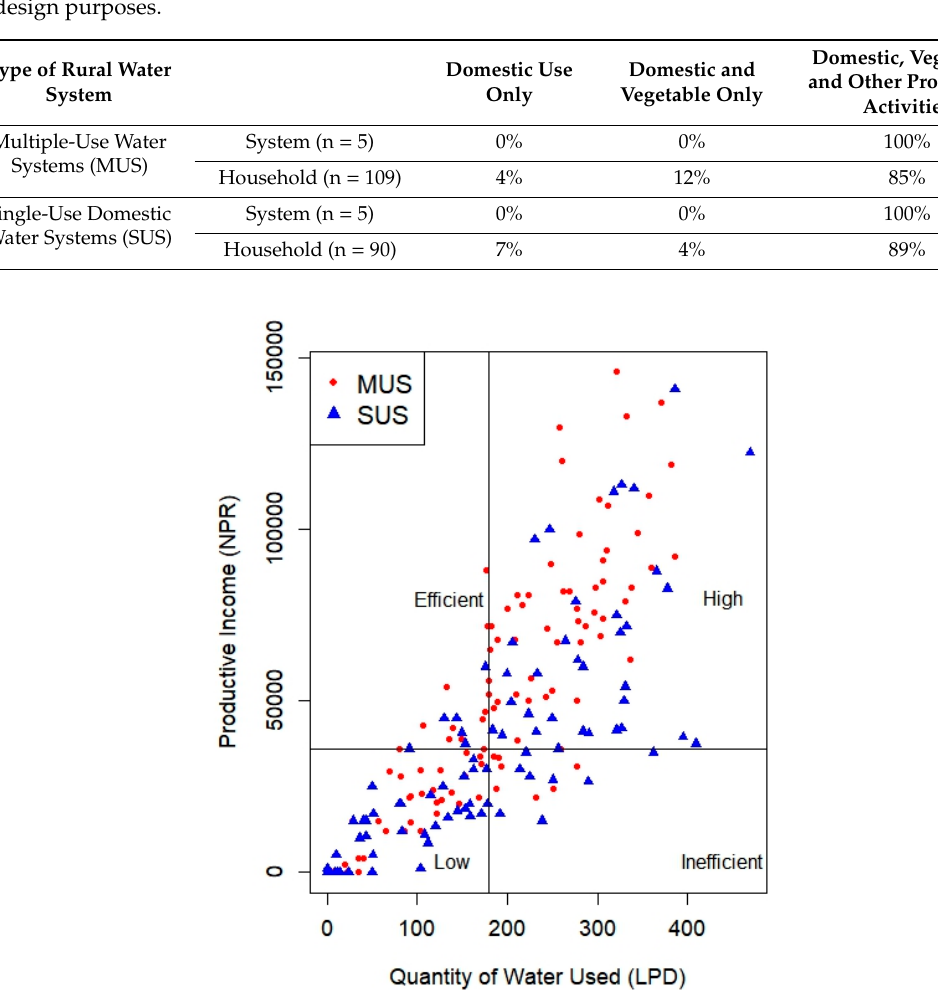
Distribution of water system and household use within and beyond the intended design purposes.